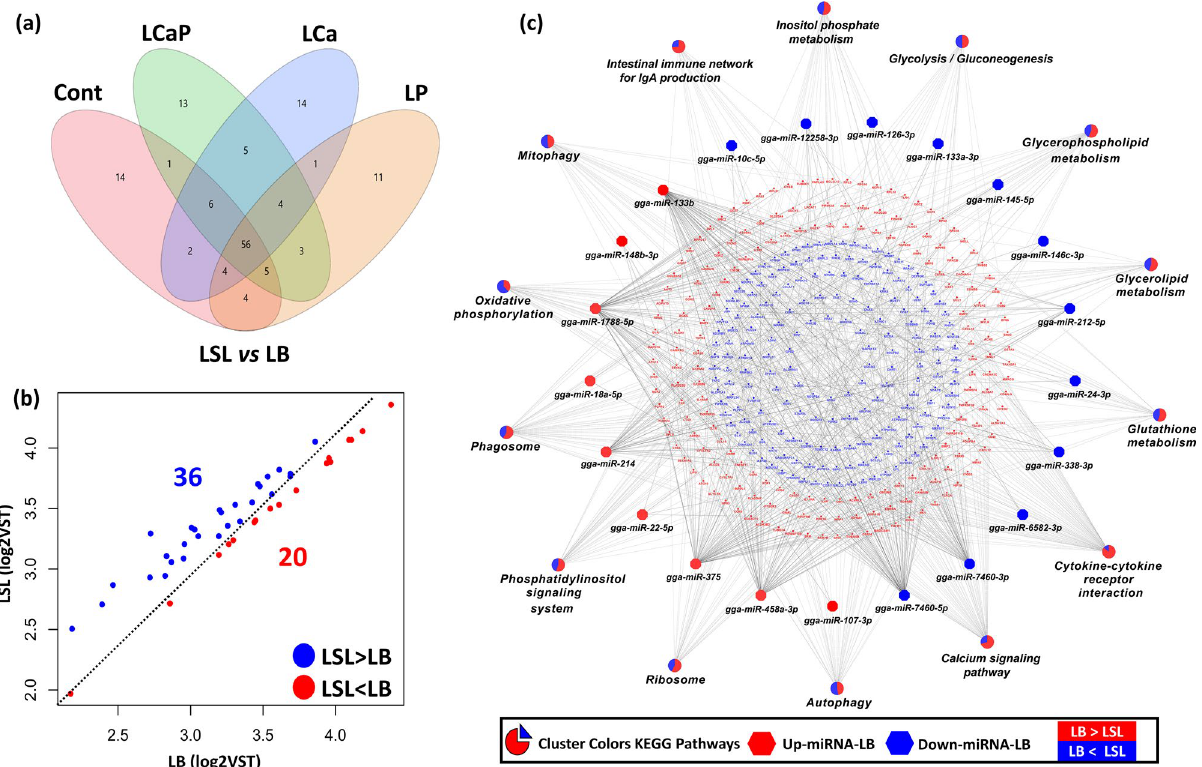
Figure 9. Comparison and KEGG Pathways Enrichment analysis of DE known miRNAs and their DE target genes between LSL and LB strains within diet groups. (a) Venn diagram indicated the deferentially expressed known miRNAs within all four diets groups between LSL and LB strain where 14, 13, 14 and 11 were specific for Cont, LCap, LCa and Lp for both LB and LSL strain respectively and 56 common DE known miRNAs. (b) Scatter plot indicated the deferential expression of 56 common known miRNAs between LSL and LB where 36 miRNAs were downregulated in LB and upregulated in LSL strain and 20 upregulated in LB and downregulated in LSL. (c) ClueGO generated functionally clustered KEGG annotation network of 56 DE known miRNAs and their DE target genes between LSL and LB. P value was calculated by right-sided hypergeometric tests and Benjamin–Hochberg adjustment was used for multiple test correction. KEGG pathways with a P < 0.05 were considered